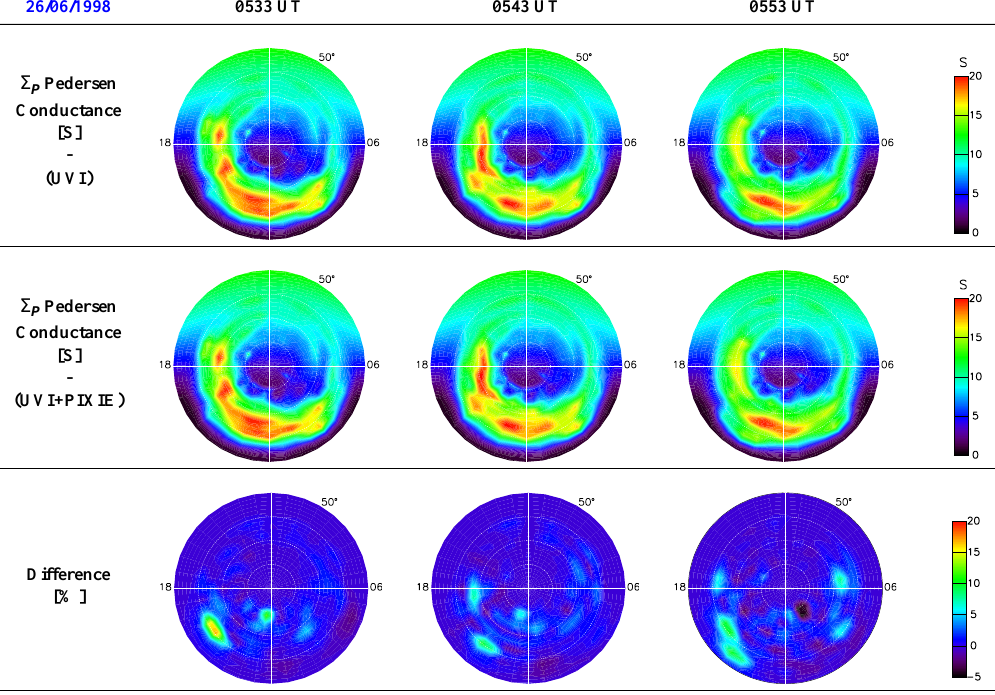
Fig. 3. Polar plots of the Pedersen conductance derived without (upper row) and with (middle row) PIXIE data between 05:30 and 06:00 UT on 26 June 1998. The differences in percent when including the PIXIE data are presented in the bottom